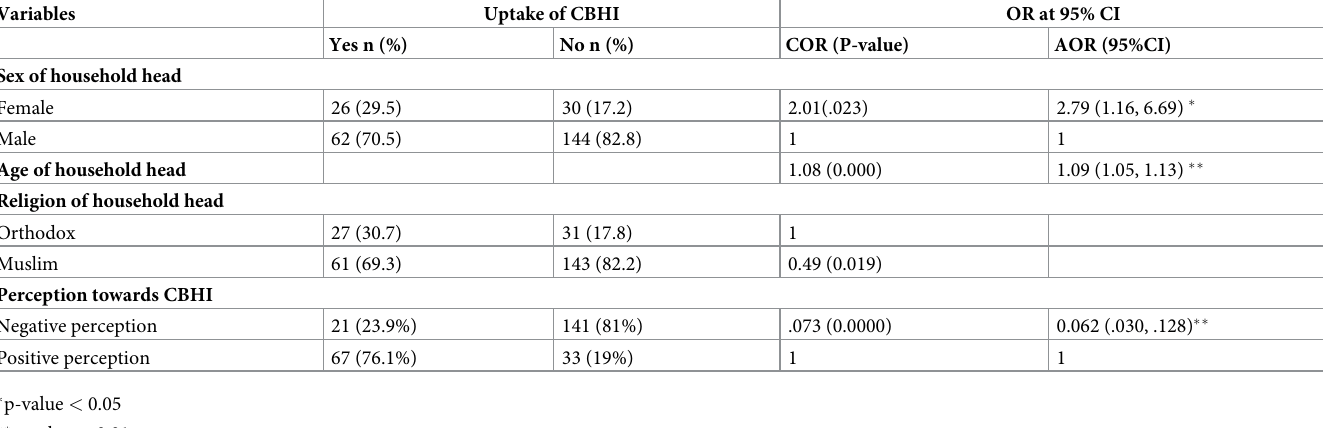
Table 2. Bivariable and Multivariable logistic regression analysis of determinants of enrollment in CBHI among respondents, in Tach-Armachiho district, North Gondar,